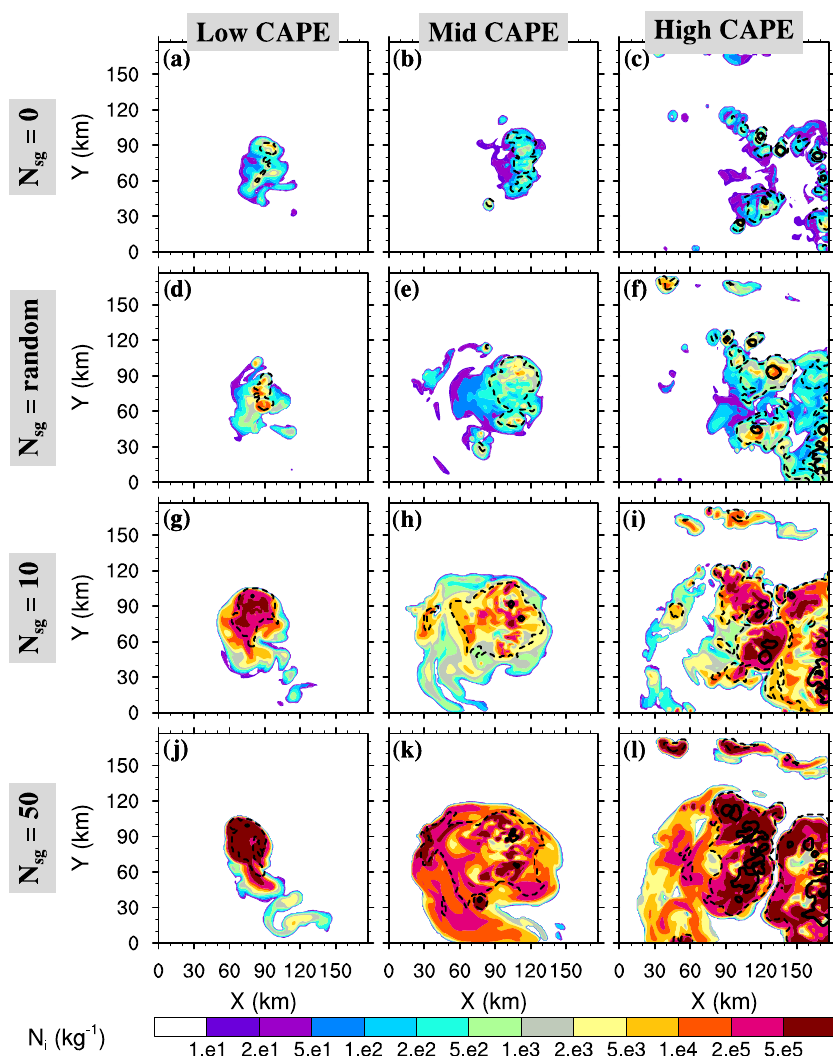
Figure 16. Small ice concentration N i average between 9.5 and 10.5km height after 4h of the WK84 simulations, where panels (a–c) refer to no CIBU cases ( N sg = 0 . 0), (d–f) to cases with random CIBU (0 . 1 < N sg < 10), (g–i) to cases with a high CIBU effect ( N sg = 10 . 0), and (j–l) to cases with an intense CIBU effect ( N sg = 50 . 0). The contours are the cloud top heights with dotted lines for 11km and solid lines for